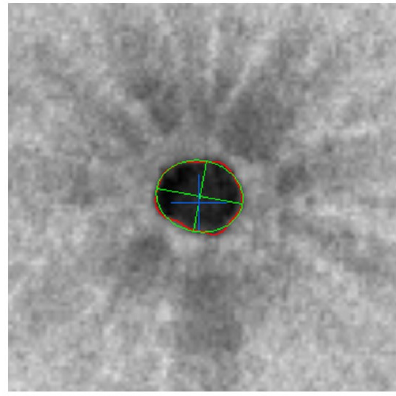
Figure 3. Representative case (3 × 3 mm en-face image). MH center distance between manual and auto was 22 µ m. Automatic detection; Extract macular hole edge showed as red line, then detect pore center (green circle, major and minor axes). Manual detected point was shown as blue cross.